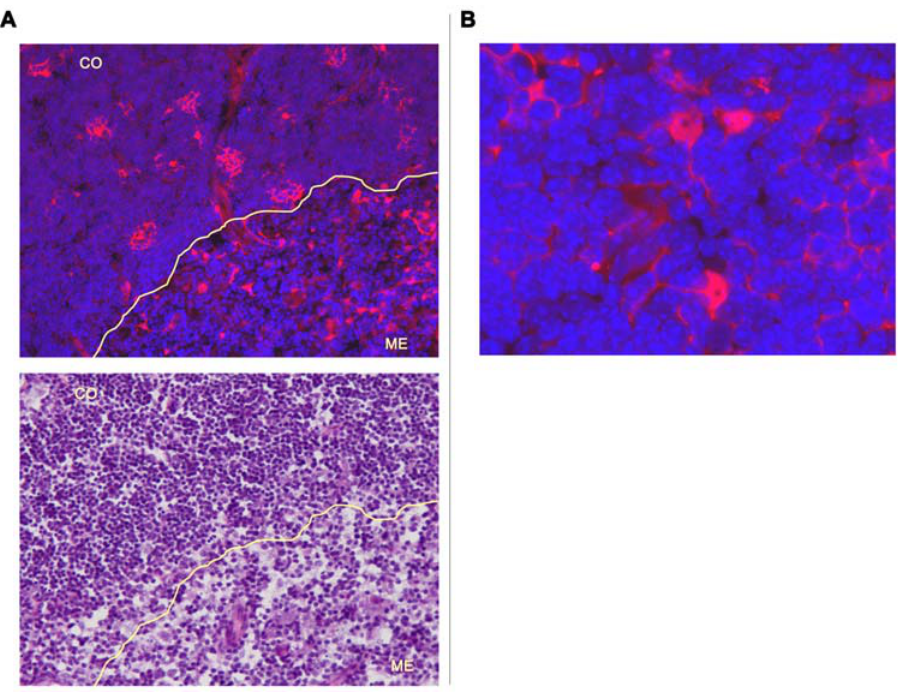
Figure 2. IL-7 is expressed in thymus. A. Expression of ECFP (or IL-7) by stromal cells in thymus is indicated by red fluorescence in the upper panel. The lower panel shows thymocytes by H&E staining on a sequential slide. The lines separate cortex (CO) from medulla (ME) in both pictures. The expression of IL-7 is higher in cortex compared to medulla and the pattern of expression is different between the two compartments. In the cortex, some IL-7 producing cells have a ‘‘basket-like’’ shape; in medulla the IL-7 producing cells are more dispersed and lacked the basket-like shape (magnification 200 6 ). B. At higher magnification (1000 6 ) it is possible to appreciate how the bodies of ECFP-positive cells are very infrequent compared to hematopoietic cells, but there are extensive reticular processes extending throughout the tissue. These reticular processes contain the ECFP protein and are in close contact with many thymocytes whose nuclei are visualized by DAPI (blue staining).